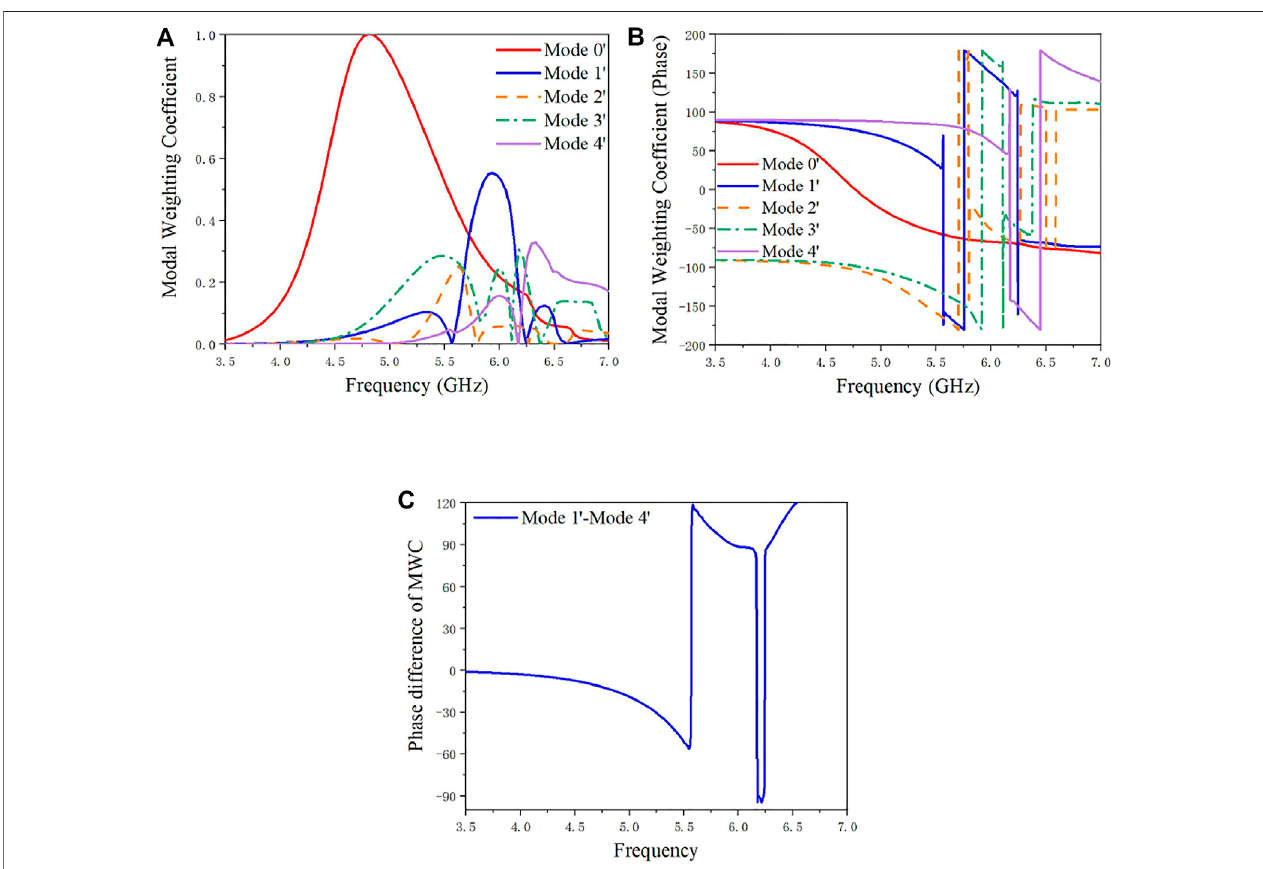
FIGURE 6 | The result of MWC: (A) Magnitude of MWC; (B) Phase of MWC; (C) Phase difference of MWC.